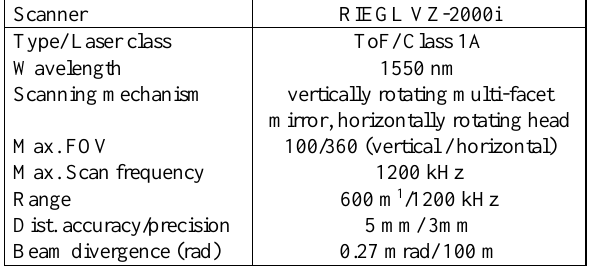
atmospheric visibility of 23 km.